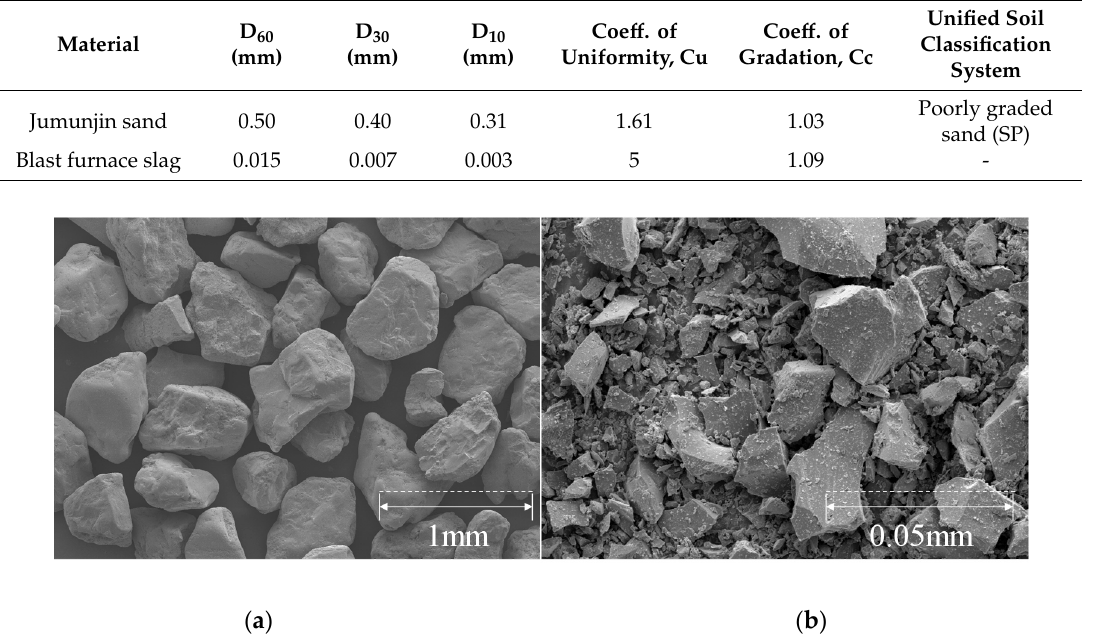
Table 2. Chemical components of Jumunjin sand.